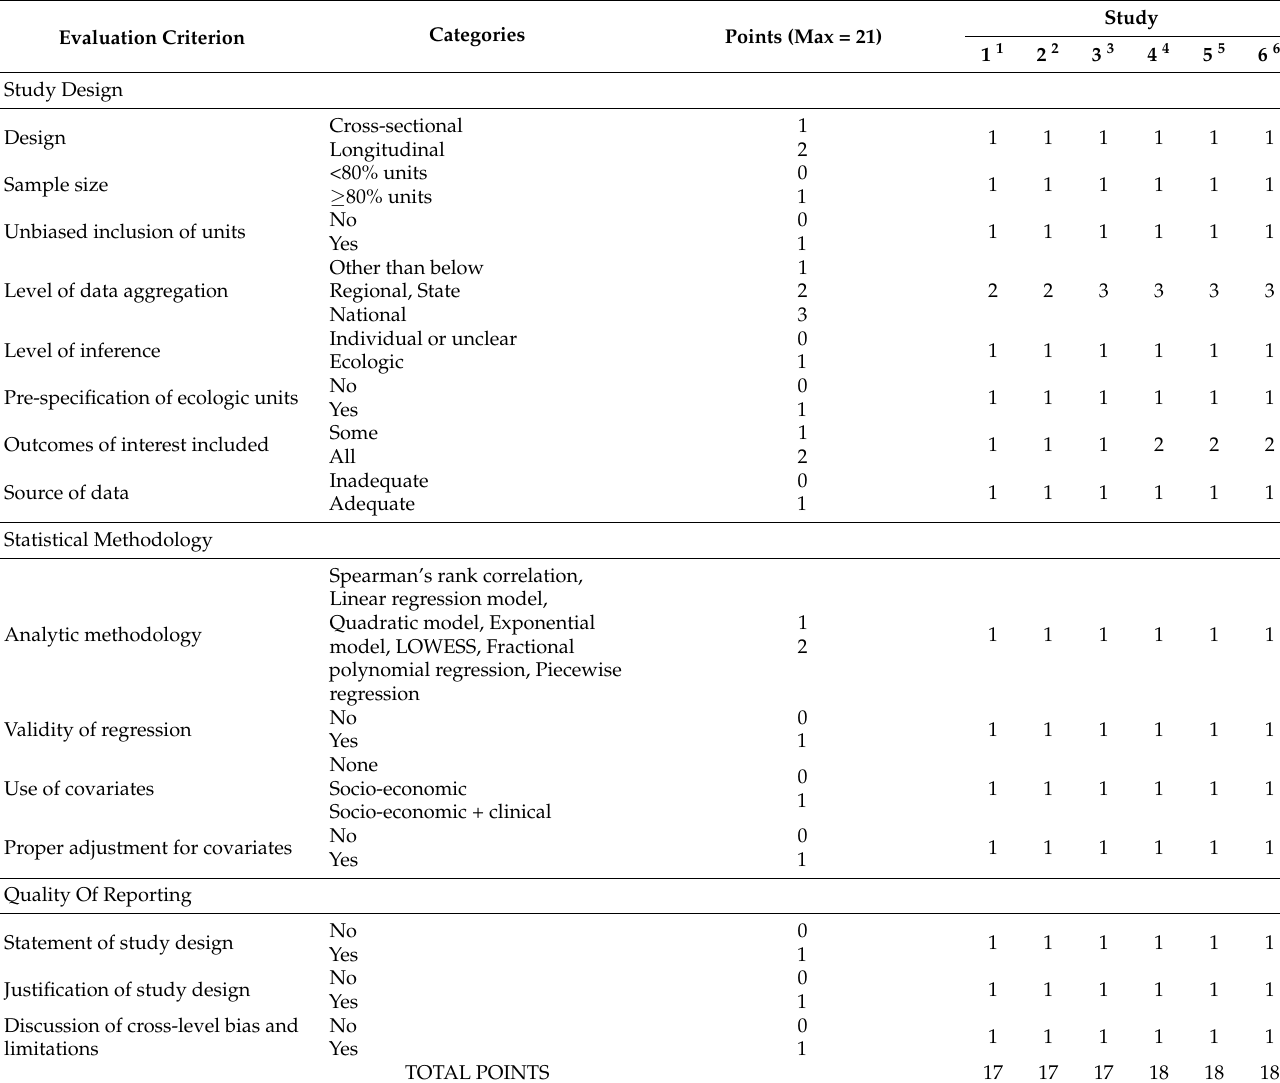
Table 3. A quality assessment of ecologic studies included in the systematic